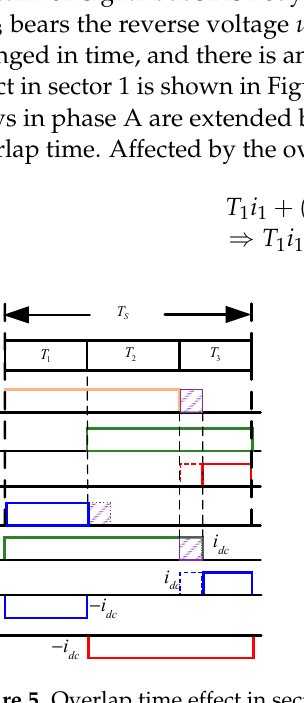
Figure 5. Overlap time effect in sector 1. The deviation of dwell time of active vectors i 2 , i 3 results in a current deviation from the expected reference current vector and introduces additional low-order harmonics in the modulated rectifier current waveforms. Figure 6 shows the current deviation i dev ( i dev = ( t ov / T s ) × i 1 ), which is mapped onto the